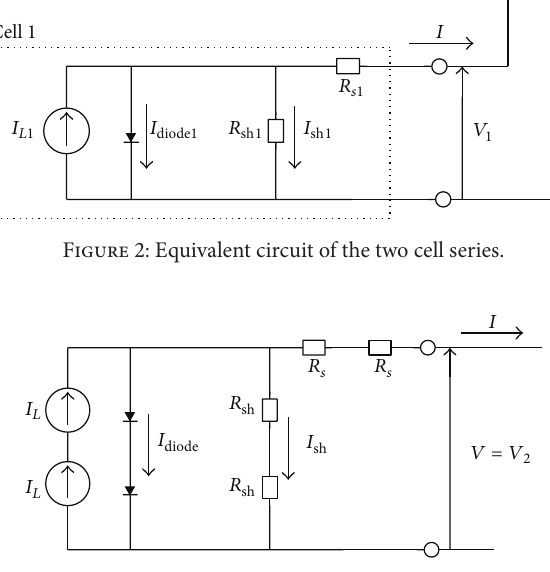
Figure 3: Equivalent circuit of a two identical cell